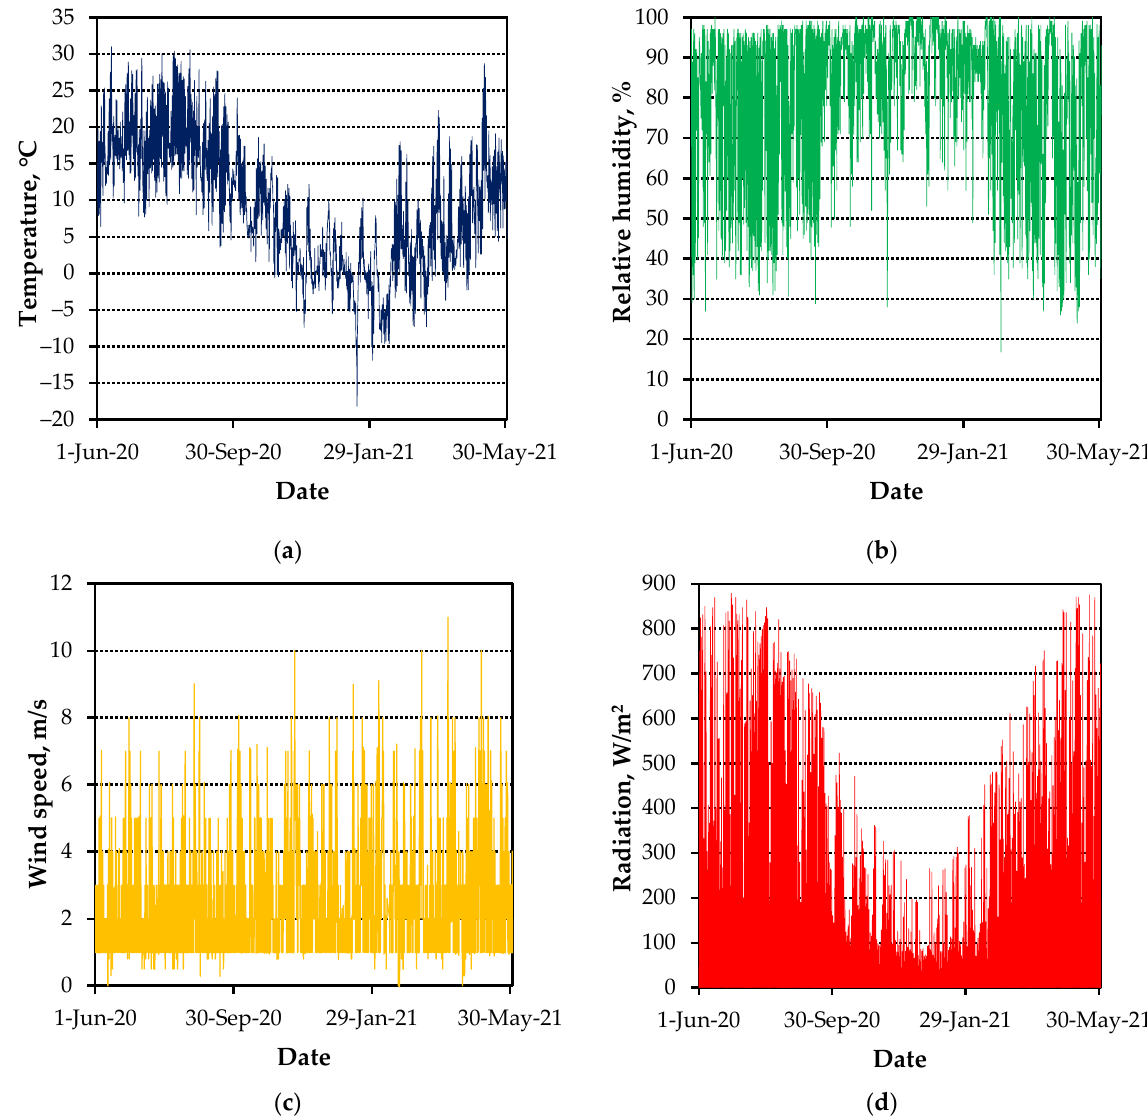
Figure 4. Climate data for the investigated year: ( a ) temperature [37]; ( b ) relative humidity [37]; ( c ) wind speed [37]; ( d ) global horizontal radiation [38].